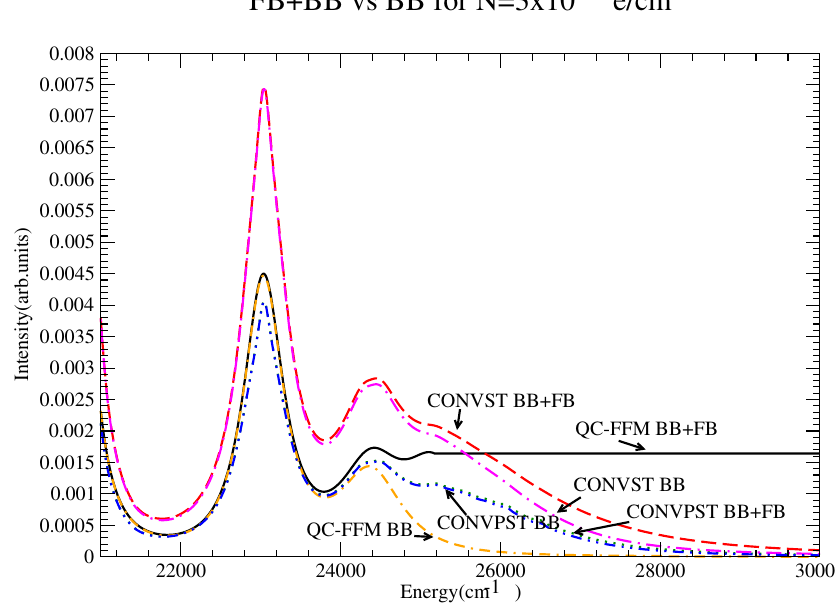
Figure 25. BB + FB vs. BB comparison for the lowest density close to the continuum. Shown are QC-FFM for BB + FB (solid) and BB only (dot-double dashed), CONVST for BB + FB (dashed) and CONVST for BB only (dash-dotted) and CONVPST for FB + BB (dotted) and BB only (dash-double dotted).